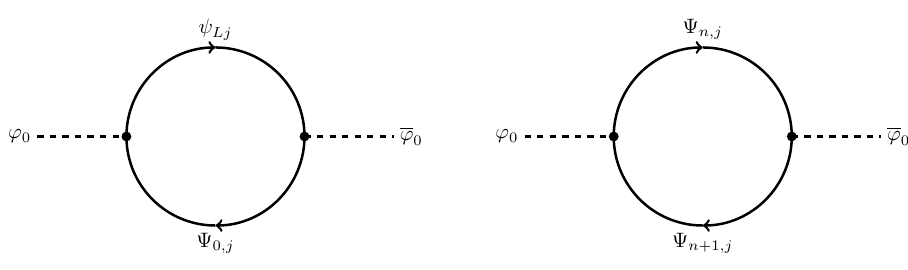
Lj and (cid:9) 0 ;j ;